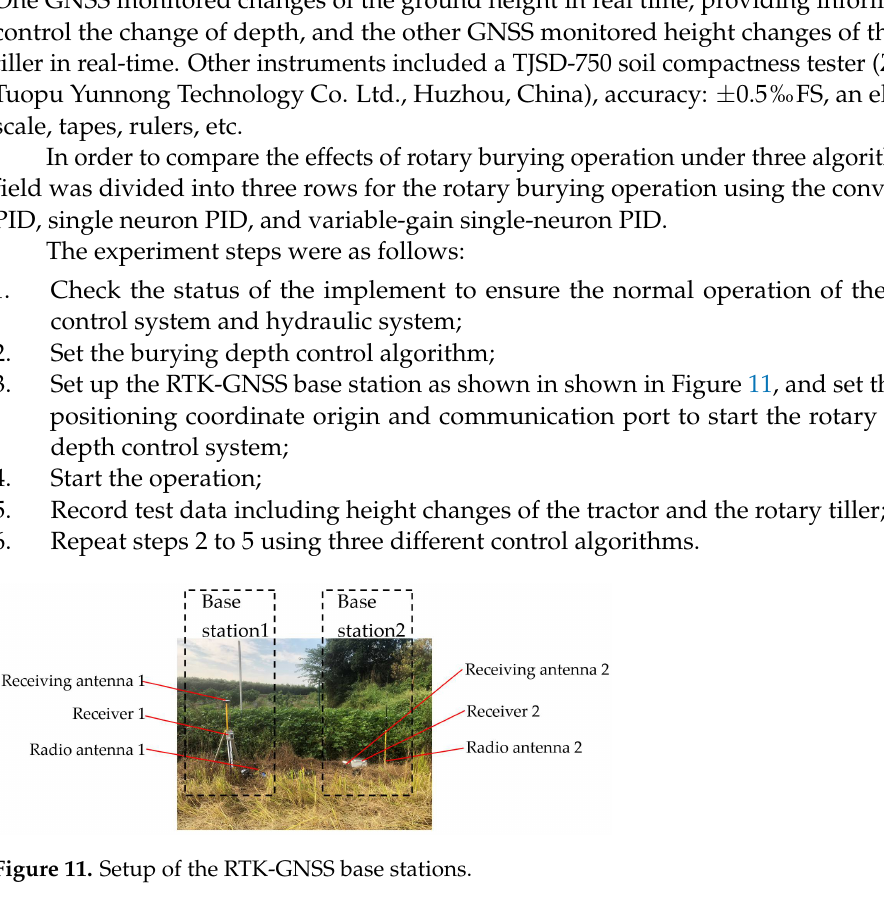
Table 2. Parameters of the field experiment conditions.